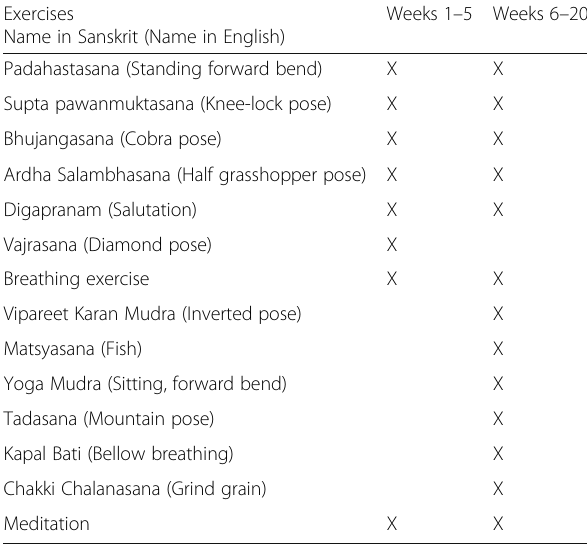
Table 3 Exercises in the Traditional Yoga treatment Exercises Name in Sanskrit (Name in